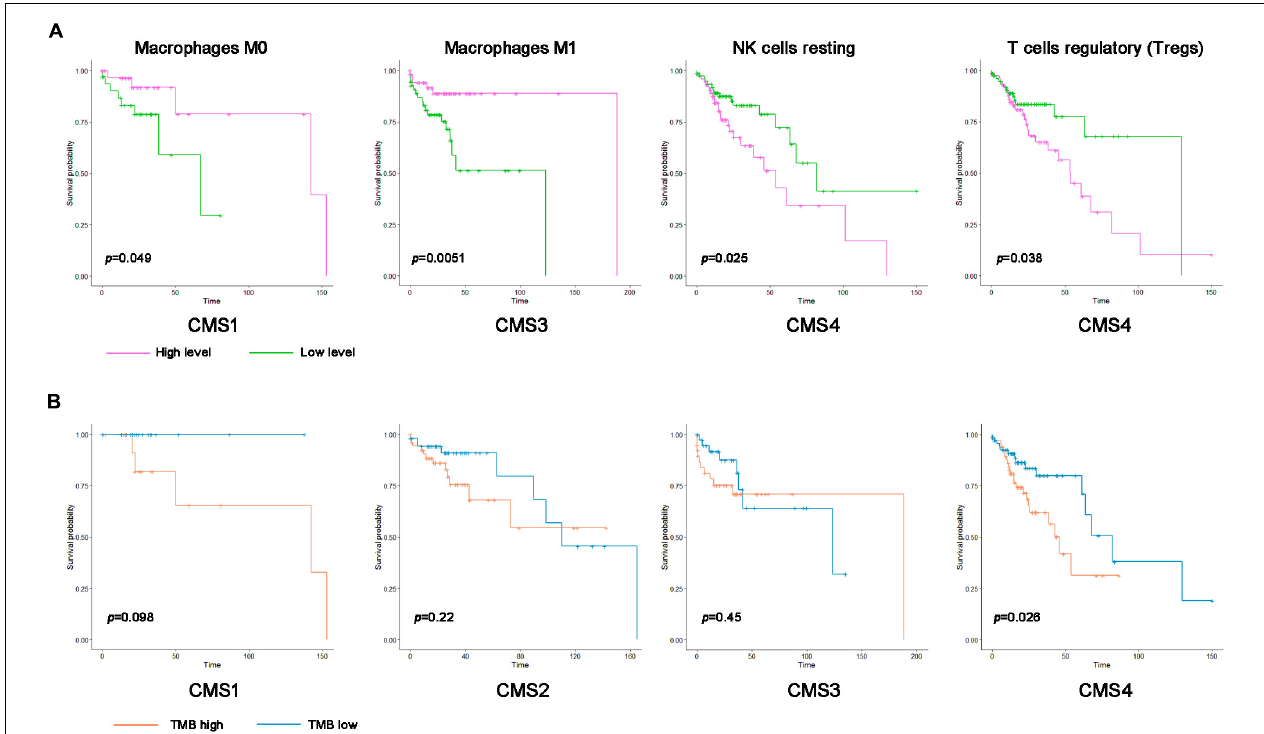
FIGURE 7 | Kaplan–Meier survival curve of immune cells and the tumor mutation burden (TMB) in the different colon cancer subtypes. (A) Kaplan–Meier survival curve of the immune cell infiltration level in the different colon cancer subtypes ( p < 0.05). Pink represents a high infiltration level, and green represents a low infiltration level. (B) Kaplan–Meier survival curve of the TMB in the different colon cancer subtypes. Blue represents the high TMB group, and orange represents the low TMB